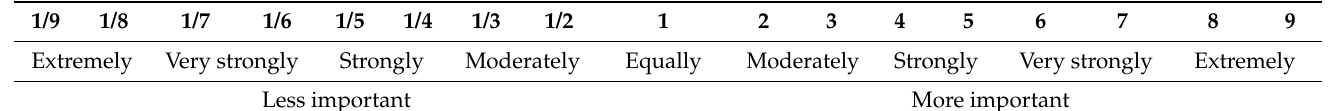
Table 2. The relative importance of two criteria